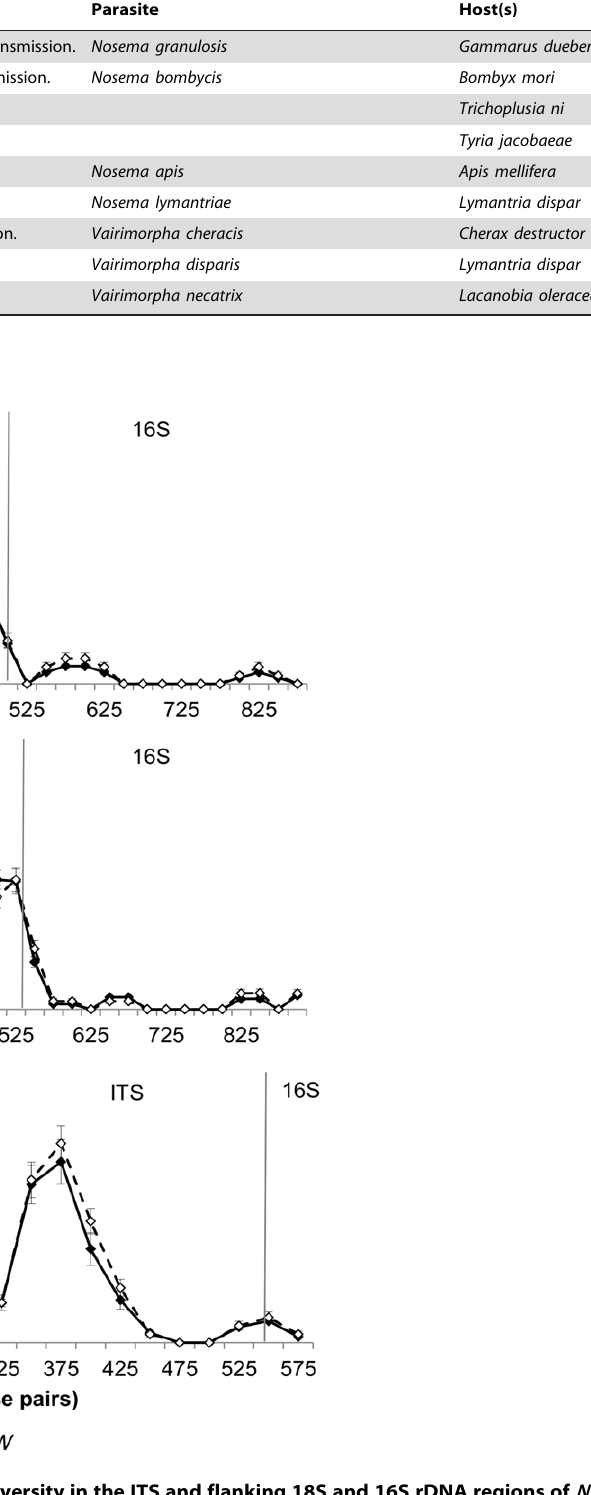
Figure 1. Sliding window analysis of nucleotide diversity in the ITS and flanking 18S and 16S rDNA regions of N.bombycis (Part A), N.granulosis (Part B) and V.cheracis (Part C). A sliding window of 50 base pairs is used, with an increment of 25 base pairs. Nucleotide diversity is calculated as the average heterozygosity per site ( p ) and the average number of nucleotide differences per site ( h W ). Error bars show the standard error for each window.